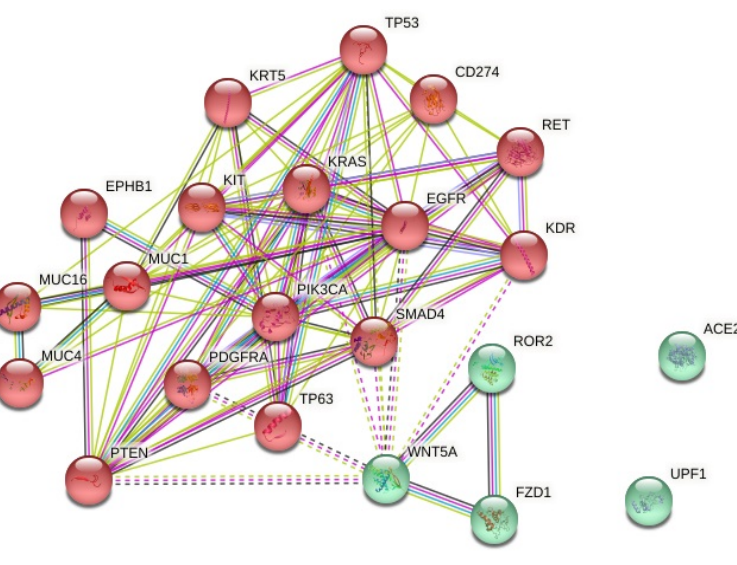
Figure 6. Genetic network analysis of ASCs.